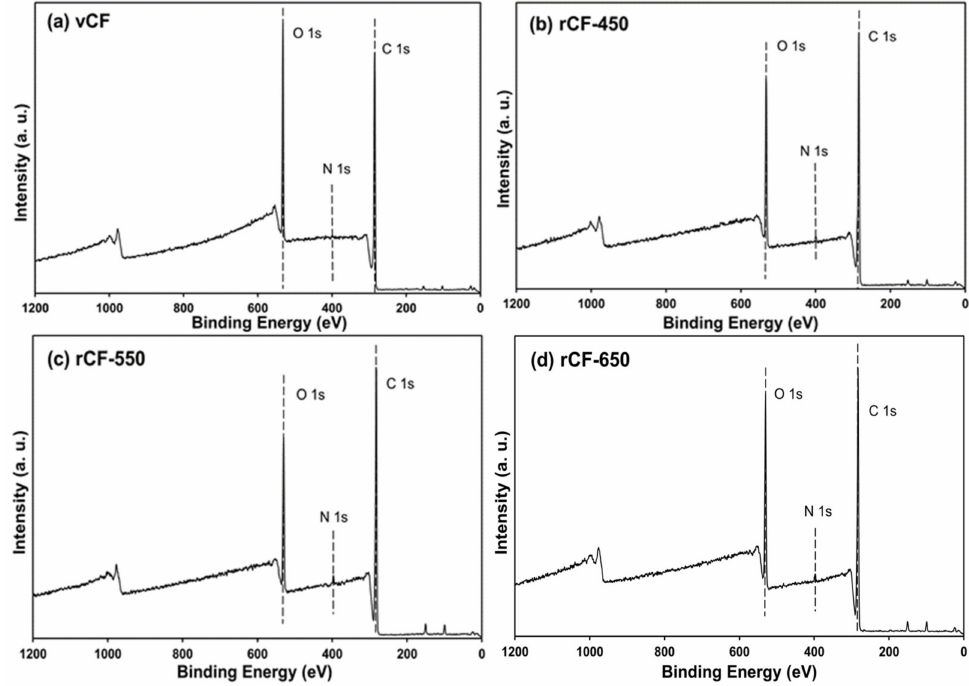
Figure 6. XPS wide-scan spectra of: ( a ) vCF; ( b ) rCF-450; ( c ) rCF-550; and ( d ) rCF-650. Table 4. The elemental concentration on the carbon fibre surface determined by XPS. Element Composition Samples